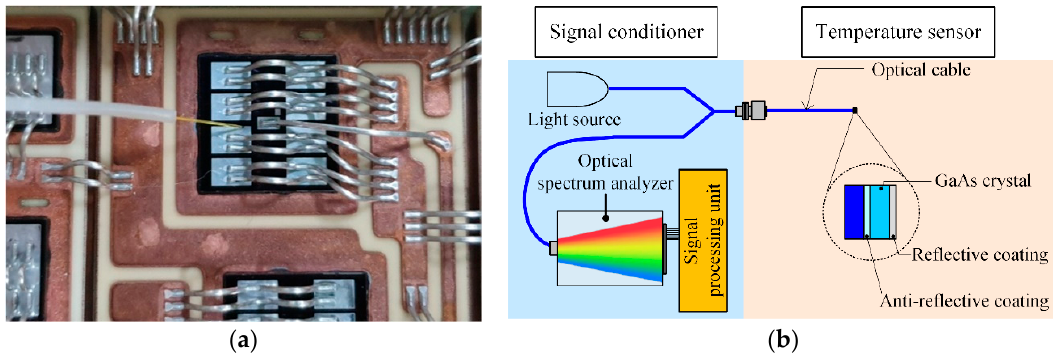
Figure 7. Measurement of the fiber-optic temperature sensor: ( a ) fiber-optic sensor mounted on the IGBT module; ( b ) temperature measurement principle of the OTG-F sensor.